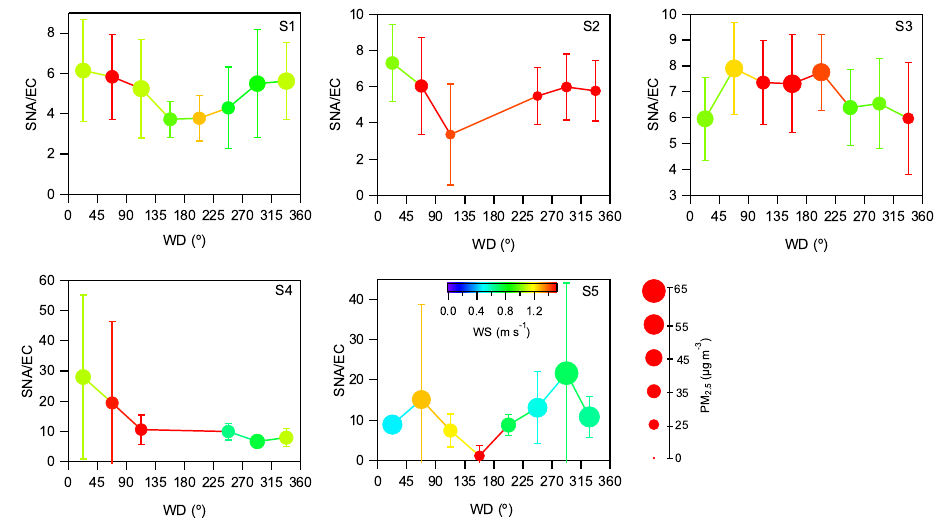
Figure 11. Variation of the ratio of SNA / PM 2 . 5 in eight wind direction sectors with a bin width of 45 ◦ during the five stages. The filled circles are colored by wind speed and the sizes of the circles correspond to the mass concentrations of PM 2 . 5 . The error bars refer to one standard deviation of the SNA / EC